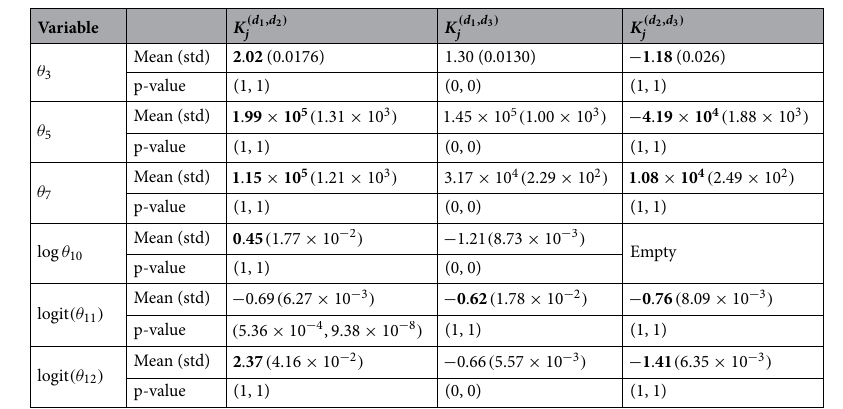
Table 2. The results of the pairwise probabilistic thresholds for the synthetic testcase found by the stochastic approximation with Polyak-Ruppert averaging after 10 4 iterations. The mean and its standard error are estimated from 20 independent runs, respectively. The p-values denote the maximum values for the one-sided t -test among 20 independent runs. The bold-typed numbers indicate that the corresponding elements are contained in the threshold K j .